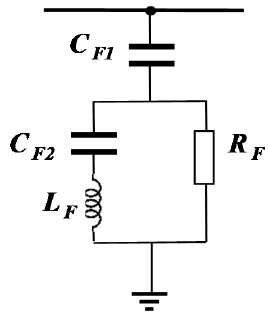
Figure 2. The per-phase equivalent circuit of the proposed C-type shunt passive filter.